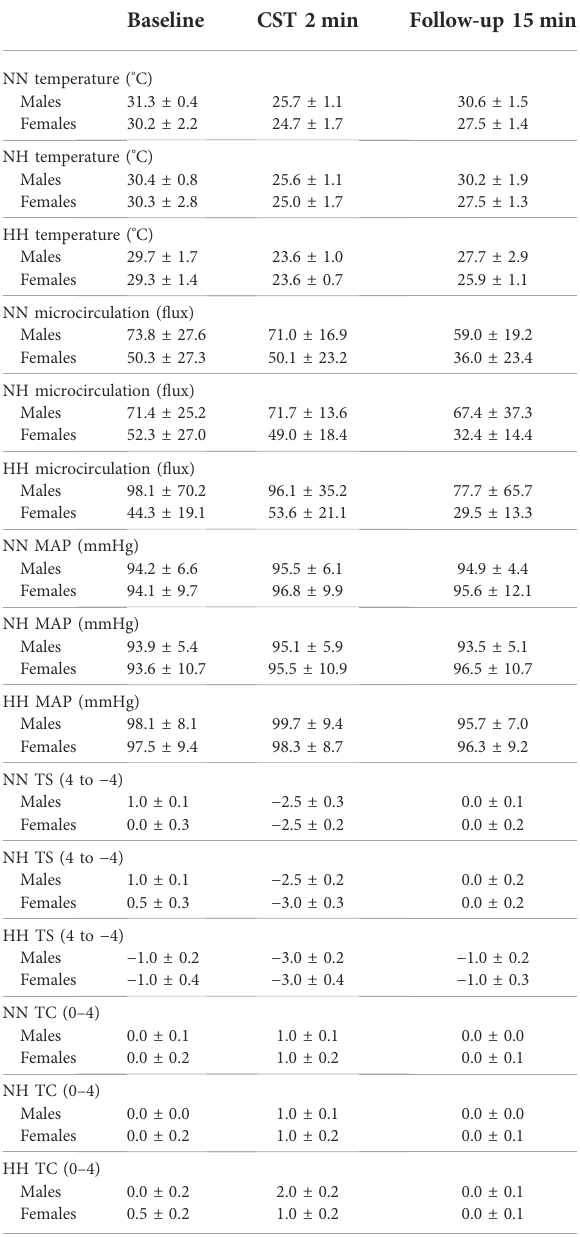
TABLE 2 Descriptive data in function of